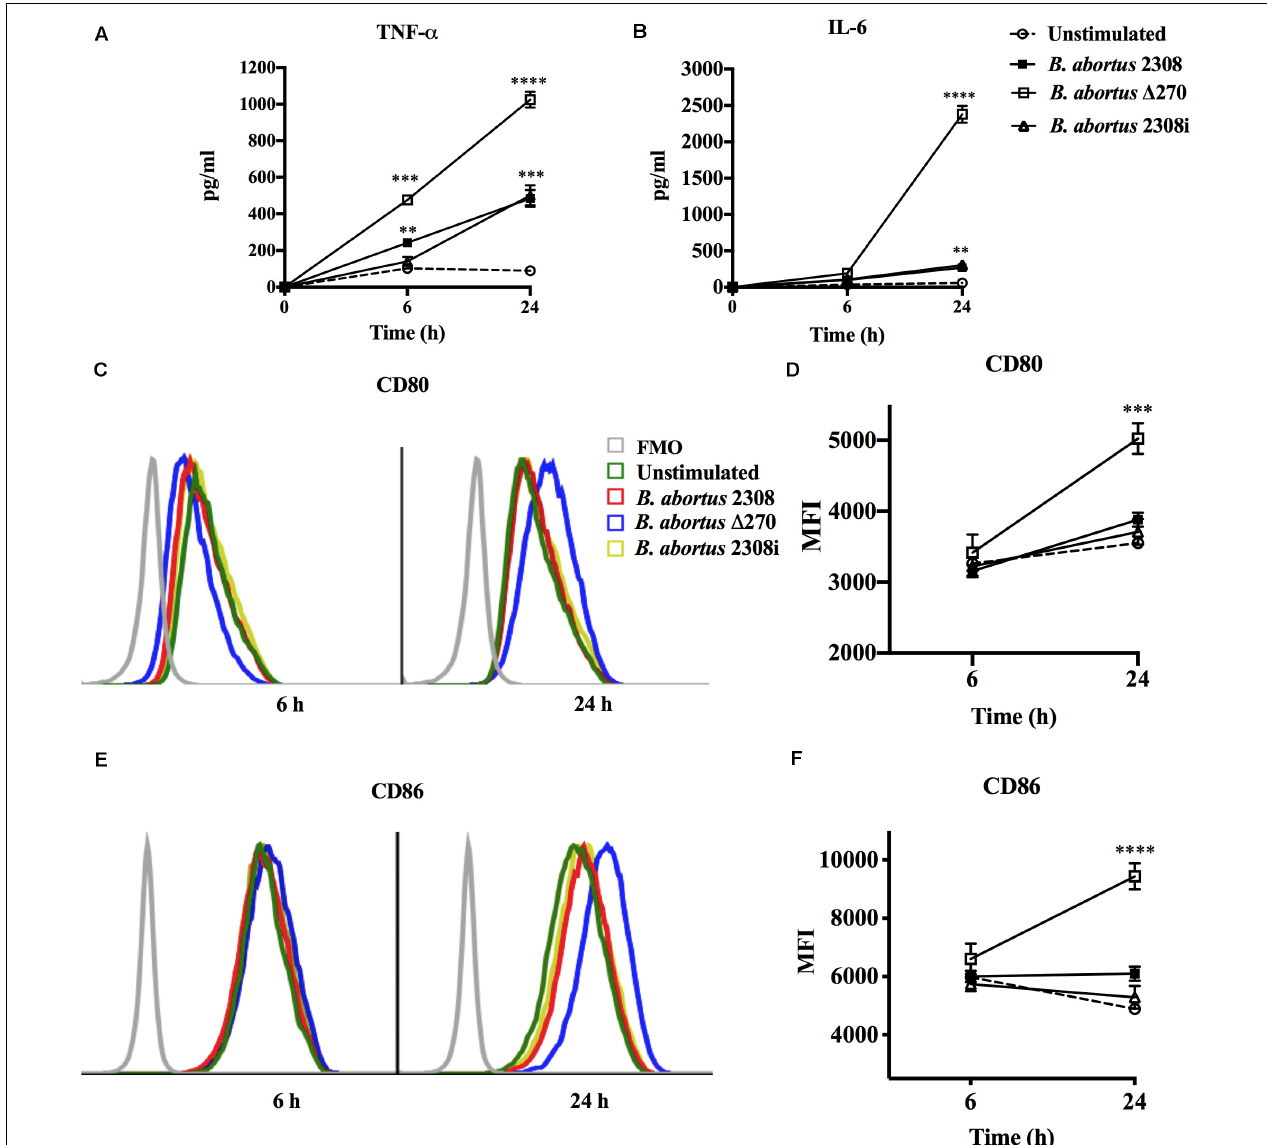
FIGURE 5 | Attenuation of B. abortus by deletion of ZnMP in macrophages. Expression of secondary signals for T cells from B. abortus strain-infected macrophages at MOI 1:10. (A) Production of TNF- α (pg/ml) and (B) production of IL-6 (pg/ml) from macrophages infected with Brucella strains were measured by Sandwich ELISA at 6 and 24 h pi with standard curves using TNF- α and IL-6 recombinant proteins. (C,E) Expression of co-stimulatory proteins CD80 and CD86 from infected macrophages measured by flow cytometry at 6 h pi (blue) and 24 h pi (red). Fluorescence minus one (FMO) was used as a negative control. (D,F) show the mean ± standard deviation of the mean fluorescence intensity (MFI) of CD80 and CD86. Data represent unstimulated (PBS-treated) macrophages, B. abortus 2308-infected macrophages, B. abortus (cid:49) 270-infected macrophages and B. abortus 2308i (inactivated strain) stimulated macrophages. Results were expressed as mean ± standard deviation. Values of P < 0.05 were considered as statistically significant, where **, ***, and **** denote values of P < 0.01, P < 0.001, and P < 0.0001, respectively. All assays were performed in